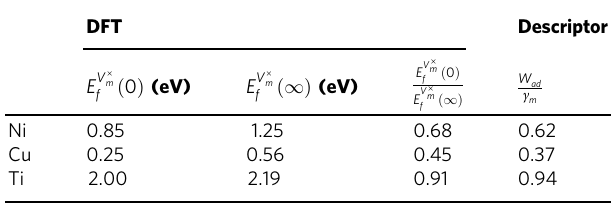
Table 1 Predictions of the descriptor compared with DFT